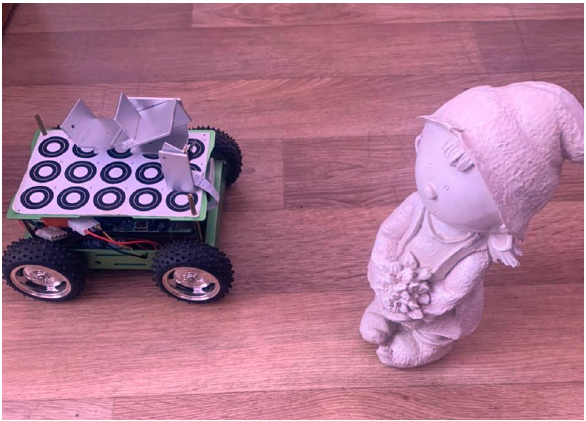
Figure 1. The mobile